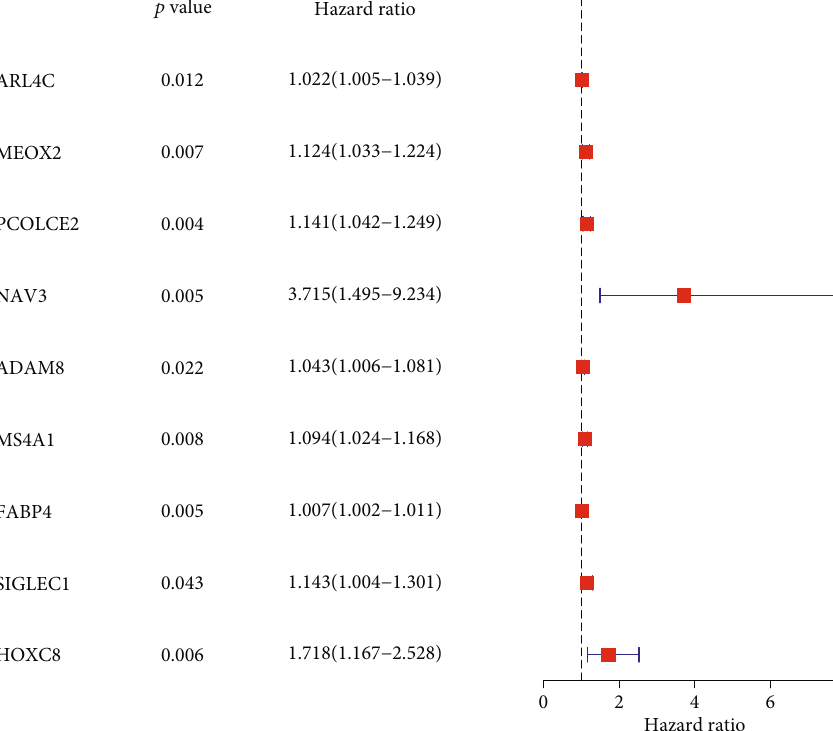
Figure 4: Univariate Cox regression investigation of